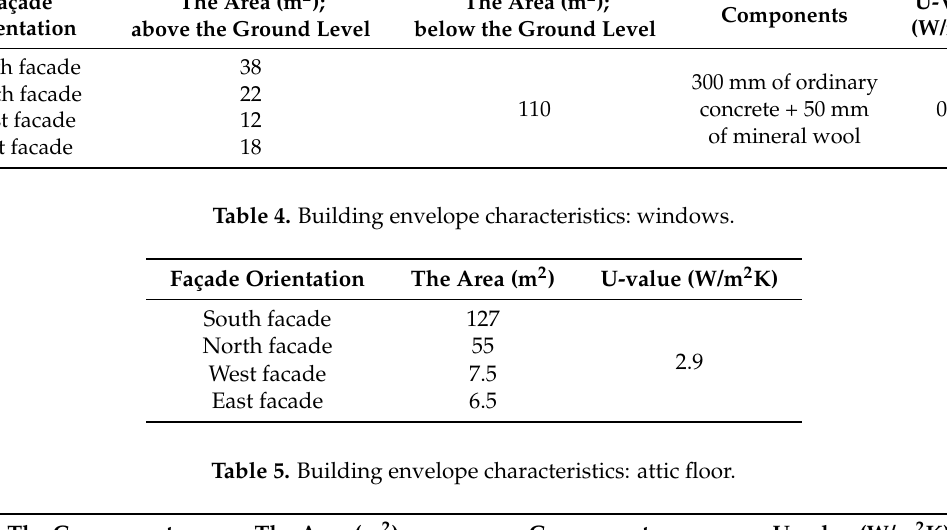
Table 3. Building envelope characteristics: basement walls.